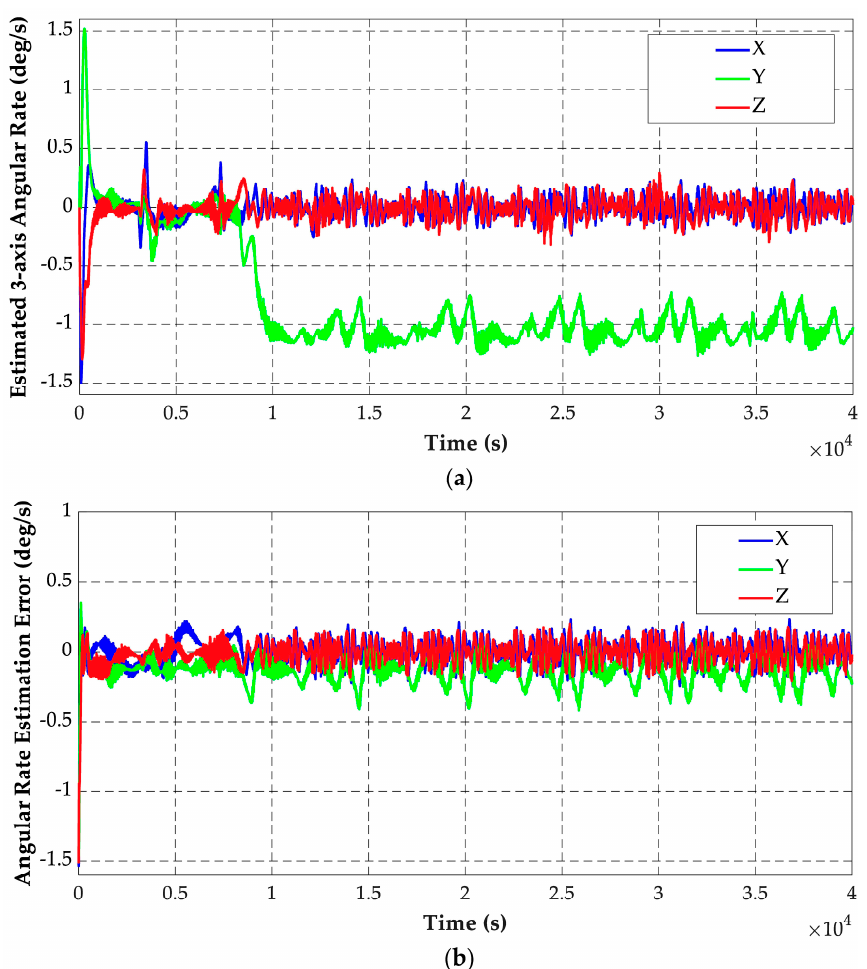
Figure 5. Simulation results of ( a ) 3-axis angular rates of the satellite estimated by rate filter; ( b ) angular rates estimation errors of rate filter.